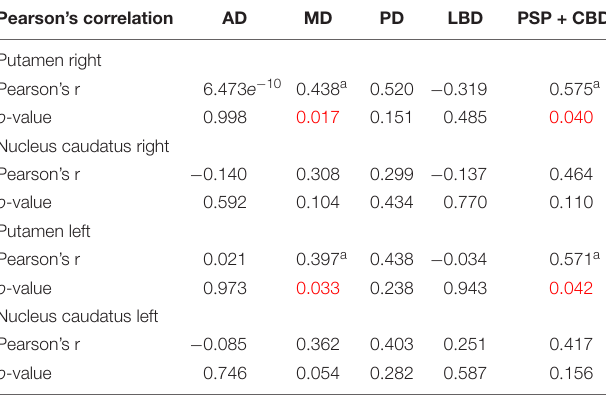
TABLE 4 | Pearson’s correlation phosphorylated neurofilament heavy chain